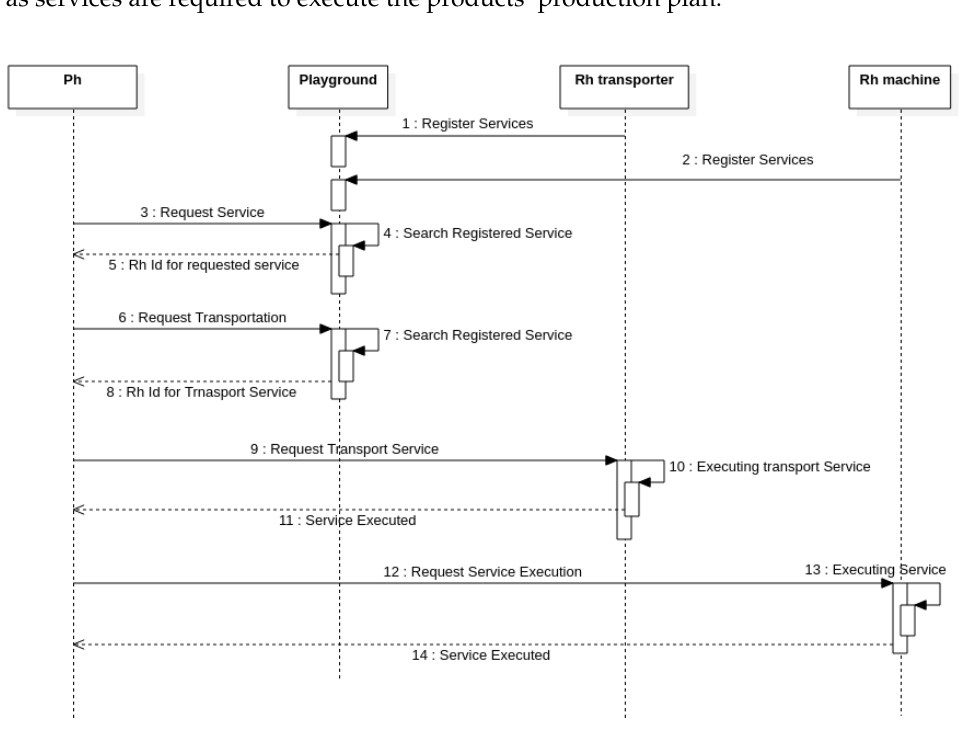
Figure 4. Sequence of actions between Playground, Rn net machine, Rh net transporter, and Ph